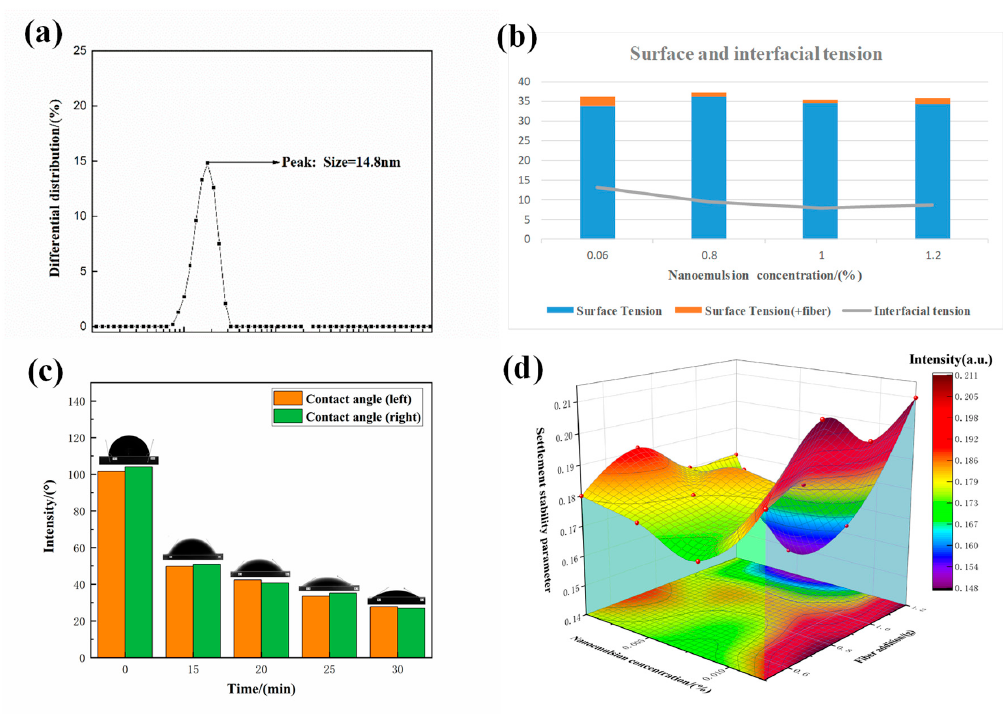
Figure 5. ( a ) Nano ‐ emulsion particle size distribution; ( b ) surface tension of nano ‐ cleaning fluid; ( c ) nano ‐ emulsion wetting reversal performance test; ( d ) stable settlement of nano ‐ cleaning fluid.